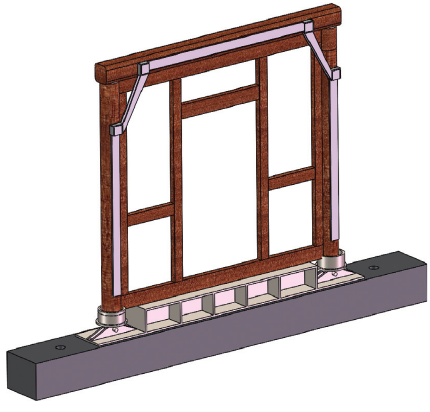
Figure 4: Specimen